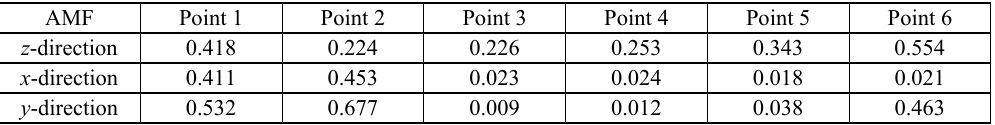
Fig. 11. AMF with the three displacement components, for the points located below the ground surface, for y = 35 m, r = 2 m; plot range: 0 < AMF < 1; (a) displacement component in the z -direction, (b) displacement component in the x -direction, (c) displacement component in the y -direction Table 2. AMF for the points 1–2 located on the foundation level and 3–6 located on the highest floor as in Fig. 1, for r = 2